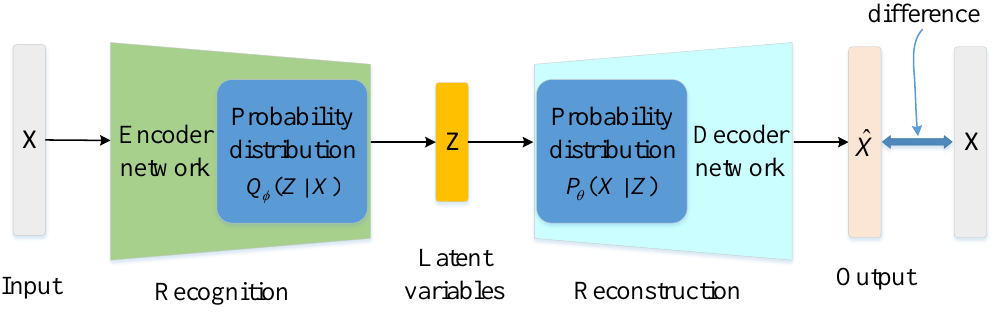
Figure 1. Variational AutoEncoder (VAE)